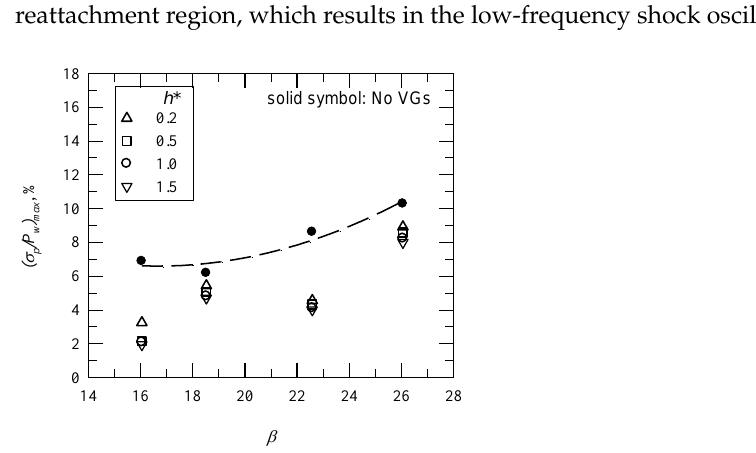
symbols: M = 0.83 solid symbols: M = 0.89